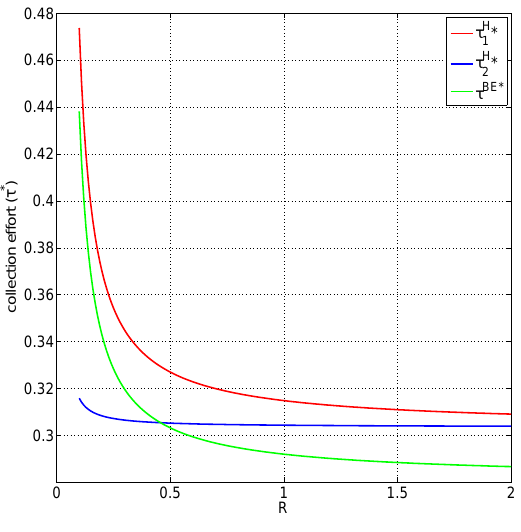
Figure 16. The influences of R on the collection effort τ